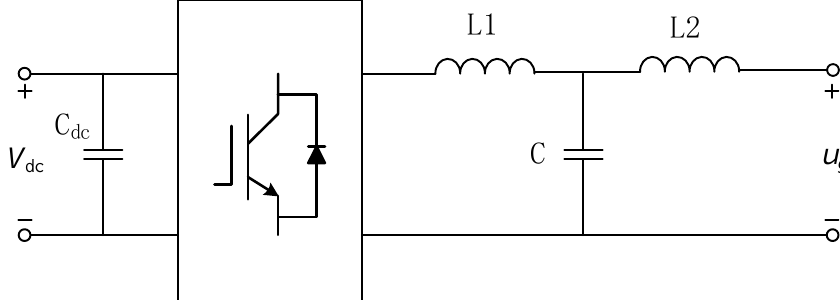
Figure 1. The LCL-type filter topology.